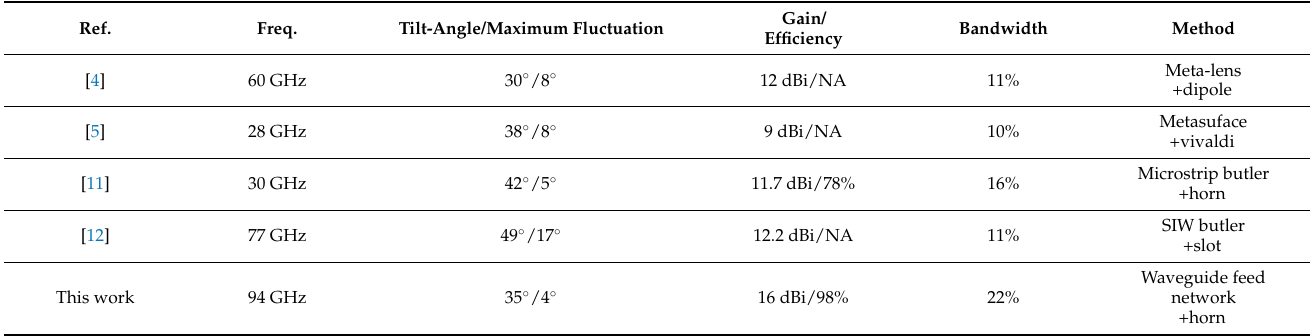
Table 2. Comparison with published works about antenna with tilted radiation beam. Ref.